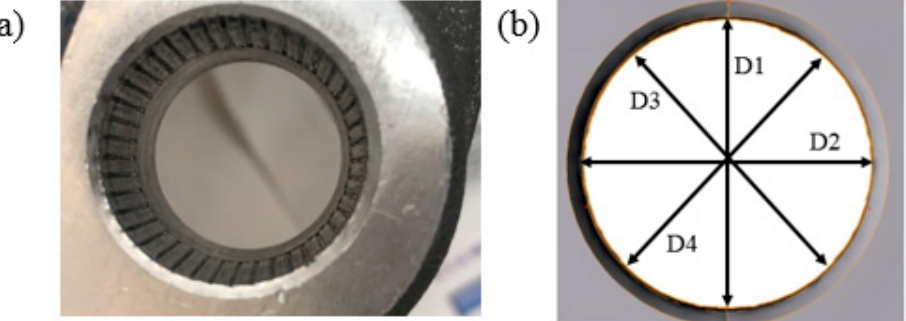
Figure 12. Hoop deformation measurement (in mm): ( a ) schematic hub of the experiment and ( b ) schematic hub of the simulation.